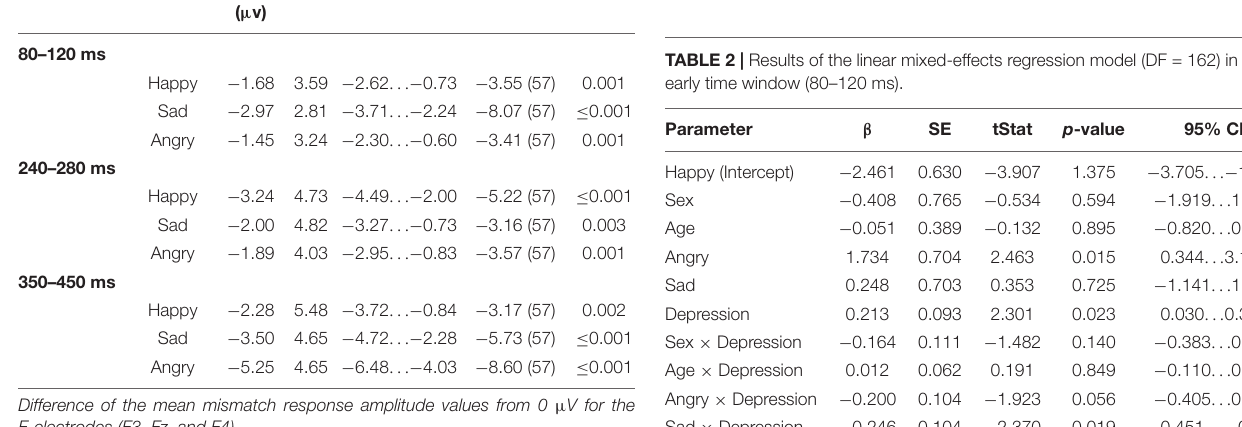
Difference of the mean mismatch response amplitude values from 0 µ V for the F-electrodes (F3, Fz, and F4).